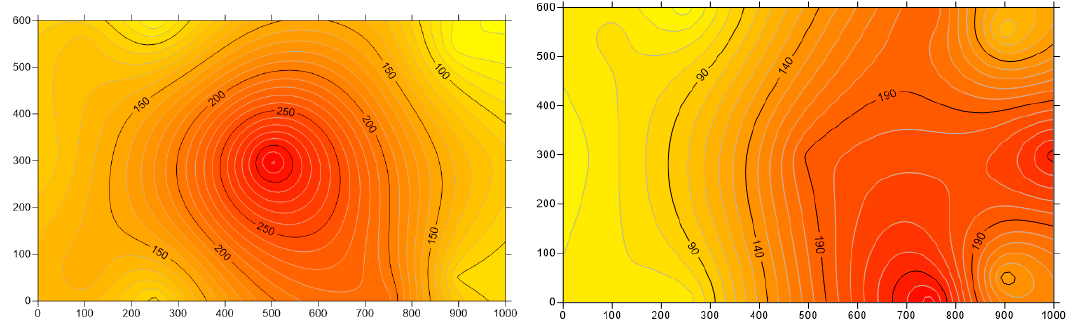
Figure 4. Initial As concentration in laboratory test ( left ) and Final As concentration in Lab test ( right ).